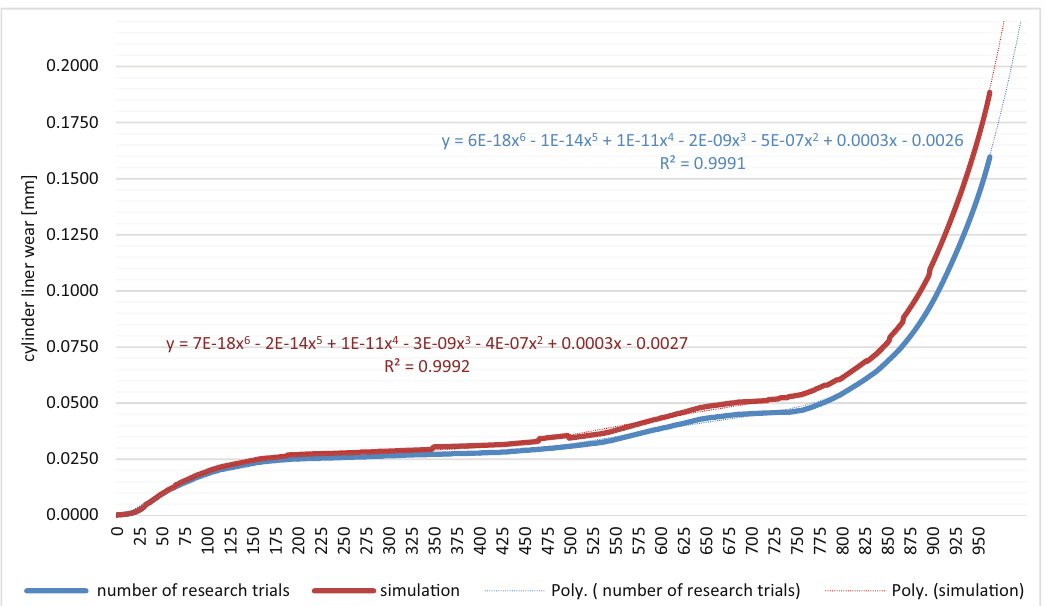
Figure 5: An approximate approximation of the average cylinder liner wear as a function of start - ups ( wear limit x = 963, y = 0.16 ) at an ambient temperature of 268